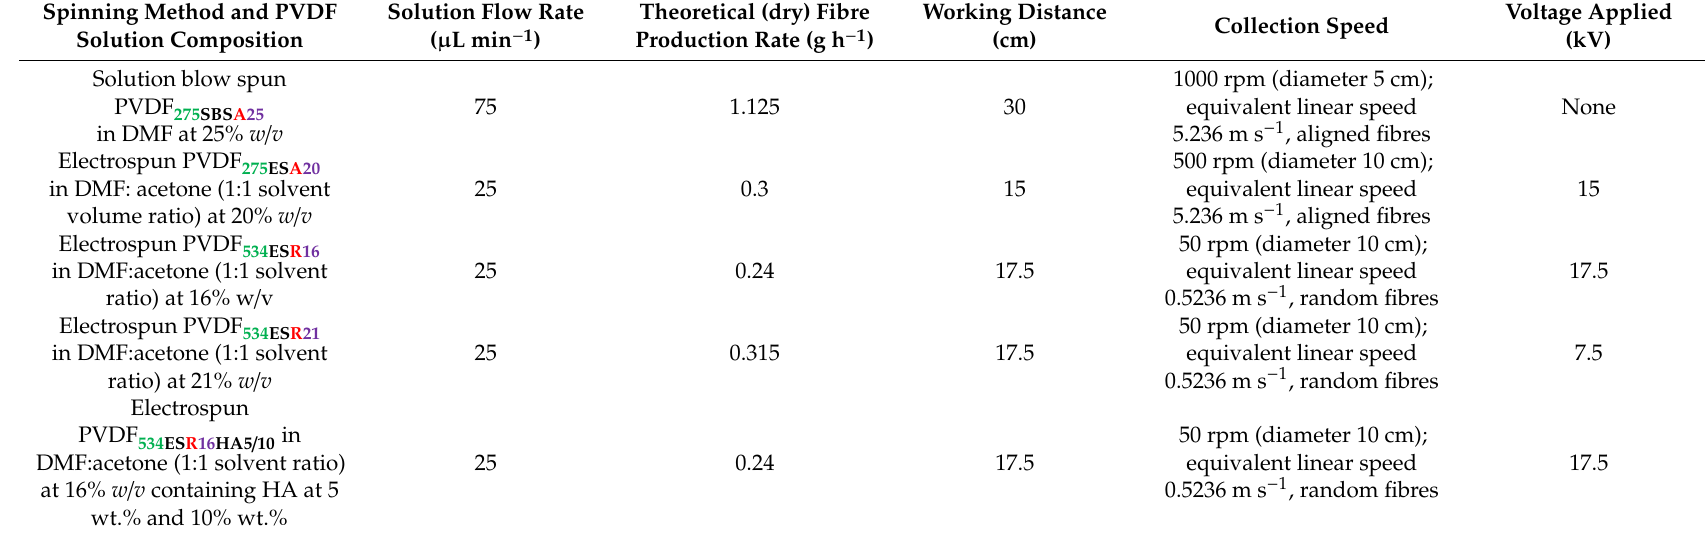
Table 1. Summary of polymer solutions and fibre spinning parameters investigated. Note that poly(vinylidene fluoride) PVDF 534ESR16 is indicative of PVDF Mw 534 kg mol − 1 (in green) spun using electrospinning (spinning technique in black) into random (R in red, as opposed to aligned, A in red) using a 16% w / v solution (in